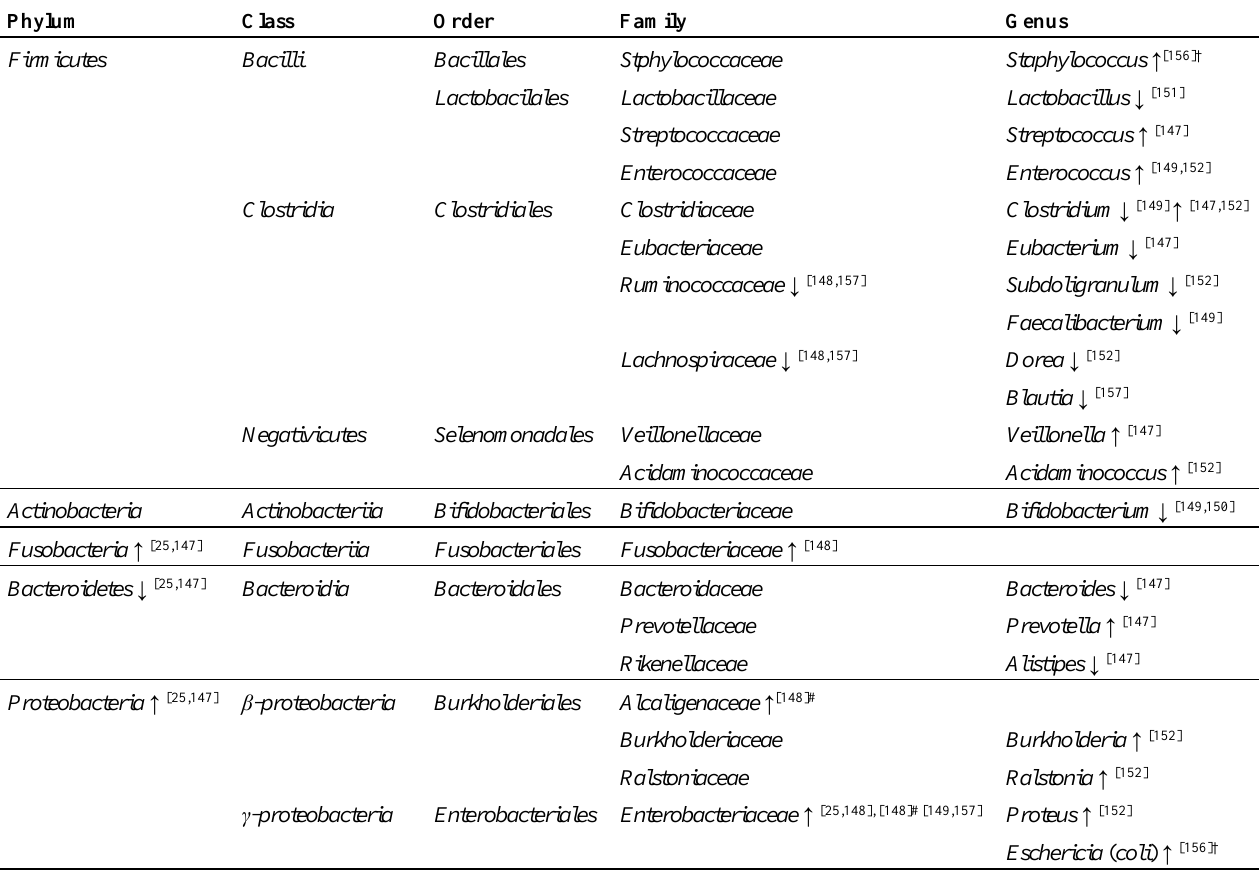
Table 4. Changes in intestinal microbiota associated with clinical studies on liver